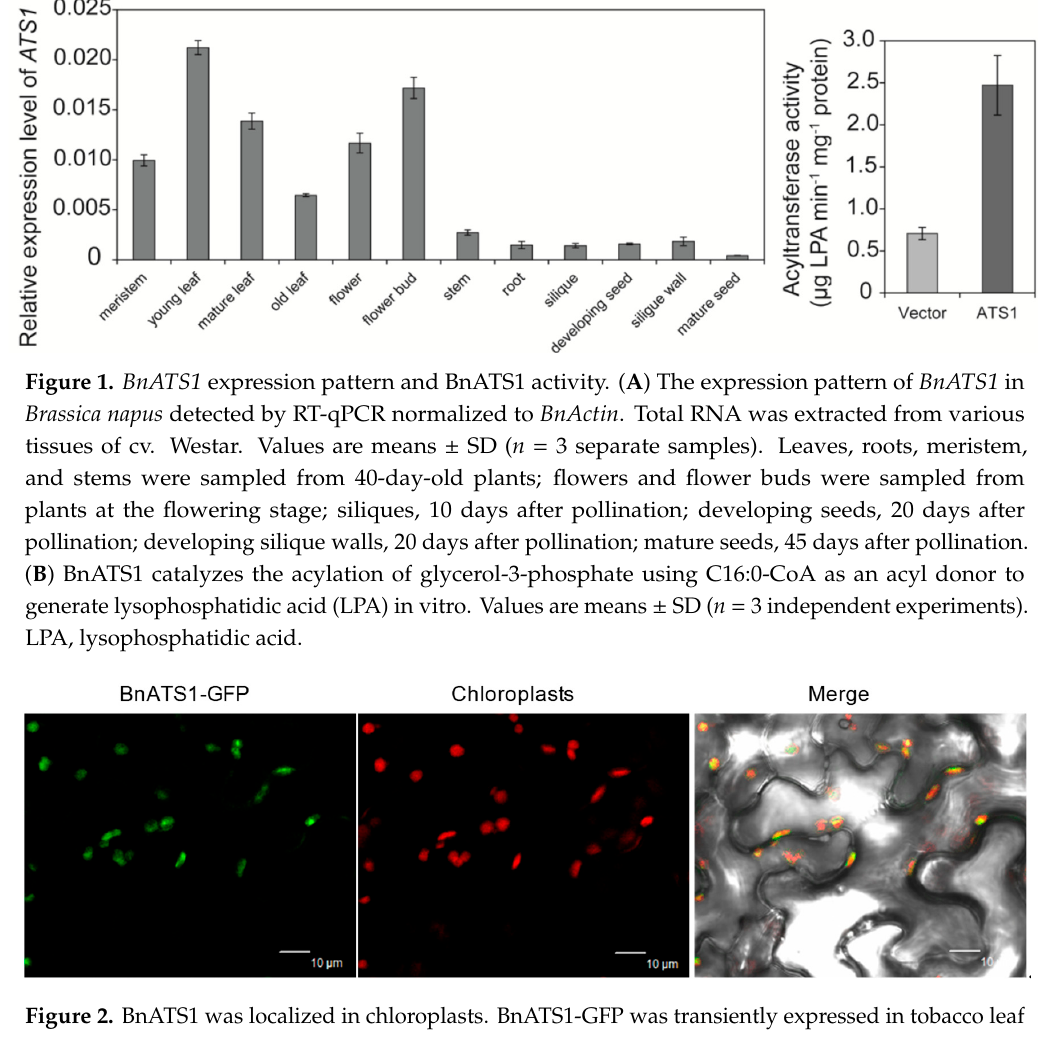
Figure 2. BnATS1 was localized in chloroplasts. BnATS1-GFP was transiently expressed in tobacco leaf cells under the control of the 35S promoter. Green fluorescent signal of BnATS1-GFP was overlaid with red auto-fluorescence produced by chloroplasts observed using a confocal laser scanning microscope. Bars = 10 μ m.